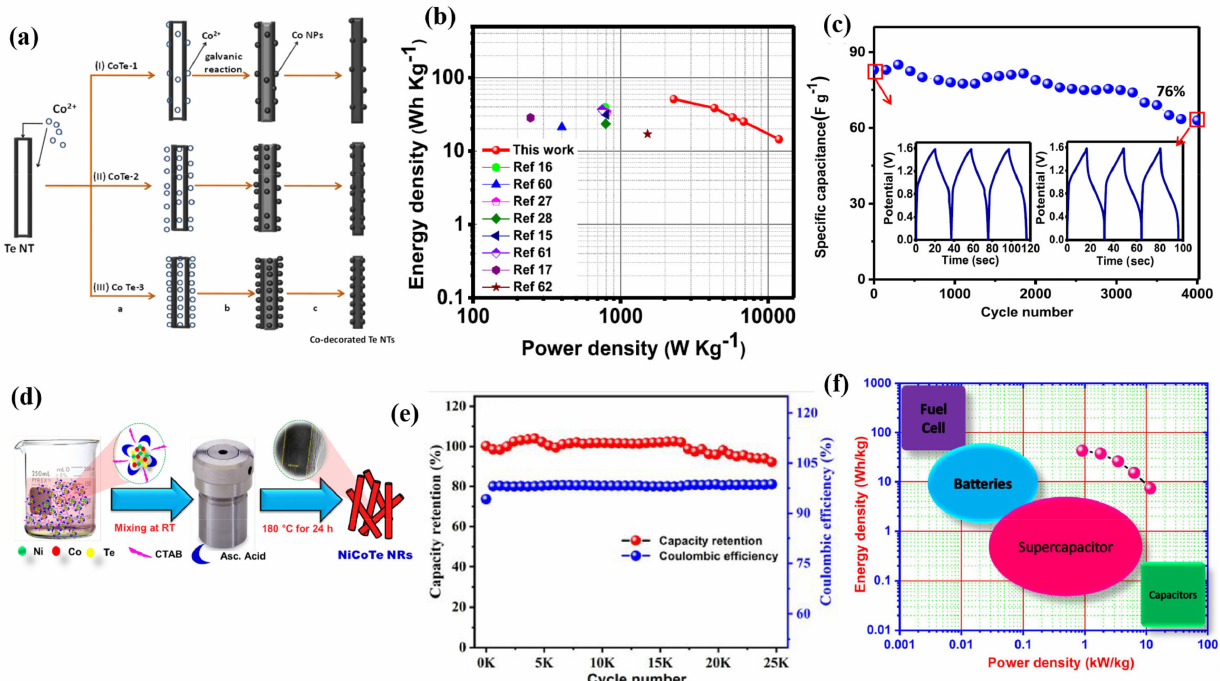
Figure 20. ( a ) Schematics of the preparation process for the formation of Co-decorated TeNTs. ( b ) Ragone plot, and ( c ) Stability measurement of CoTe-2//AC at 4 A/g in a two-electrode setup. Adapted with permission [365]. Copyright (2021) American Chemical Society. ( d ) Illustration process for NiCoTe NR preparation. ( e ) Specific capacity and columbic efficiency vs. cycle number, and ( f ) Ragone plot for the fabricated ASC cell. Adapted with permission [366]. Copyright (2021) American Chemical